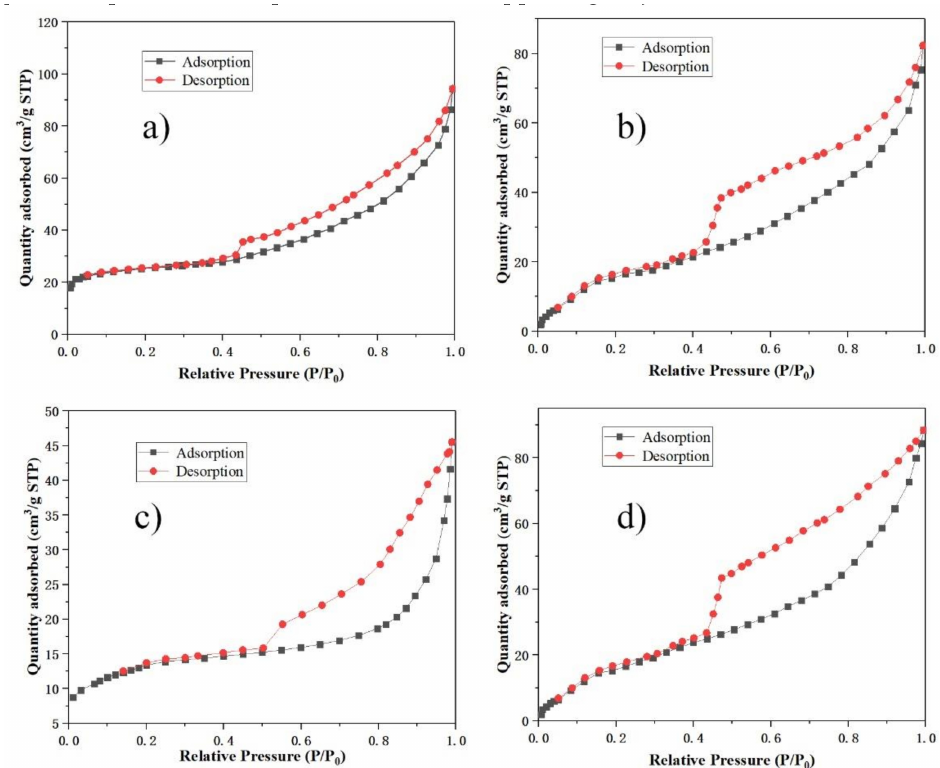
Figure 9. N 2 adsorption and desorption isotherms of samples A2-T90-H24 ( a ); A3-T90-H24 ( b );